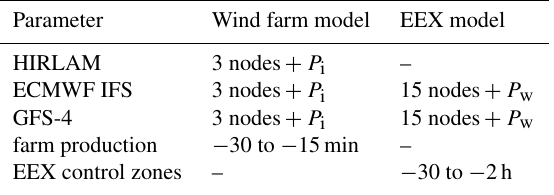
Table 2. Input data for the DNN models, the setup of which was derived from previous experiments with deterministic forecasts. We use several wind power relevant fields from each NWP model, at nodes spread around the region of interest. P i means a “physi- cal” power forecast without corrections, derived by interpolating the respective NWP model to the wind farm location and passing it through the plant’s power curve. P w is a capacity weighted sum of the same quantity over